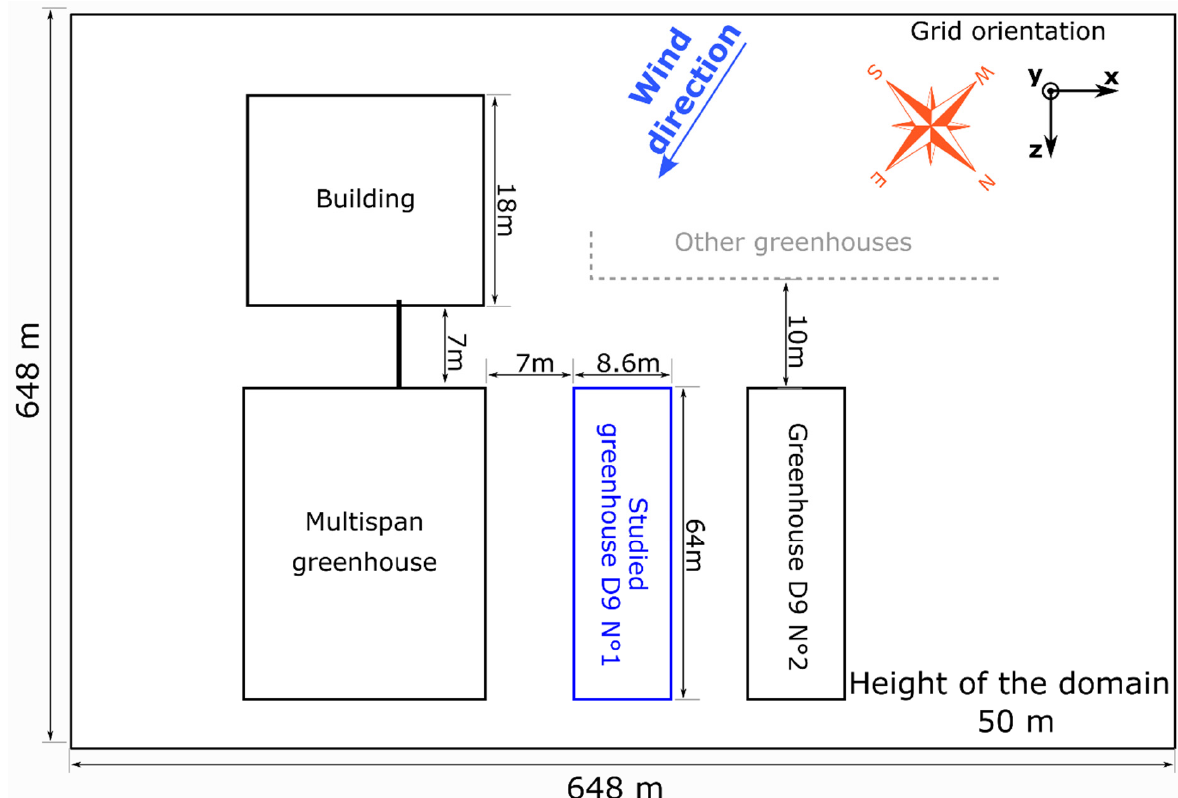
Figure 2. Computational domain and greenhouse orientation used for the simulation.